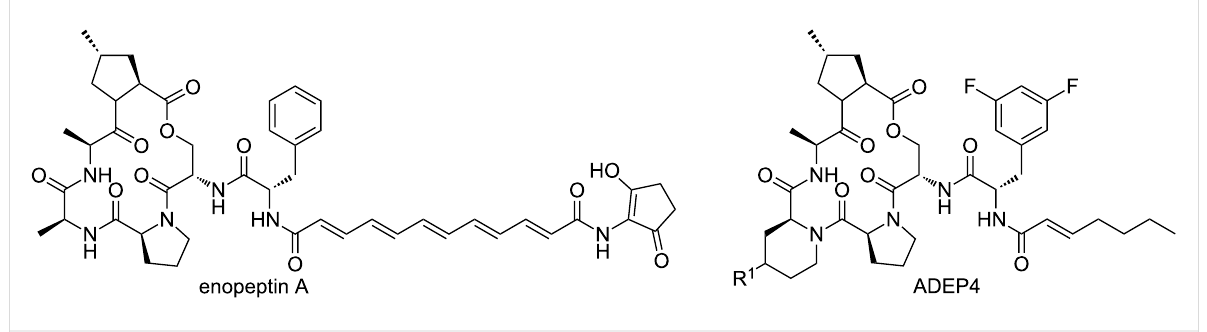
Figure 4: Enopeptin A with its more active derivative ADEP-4.